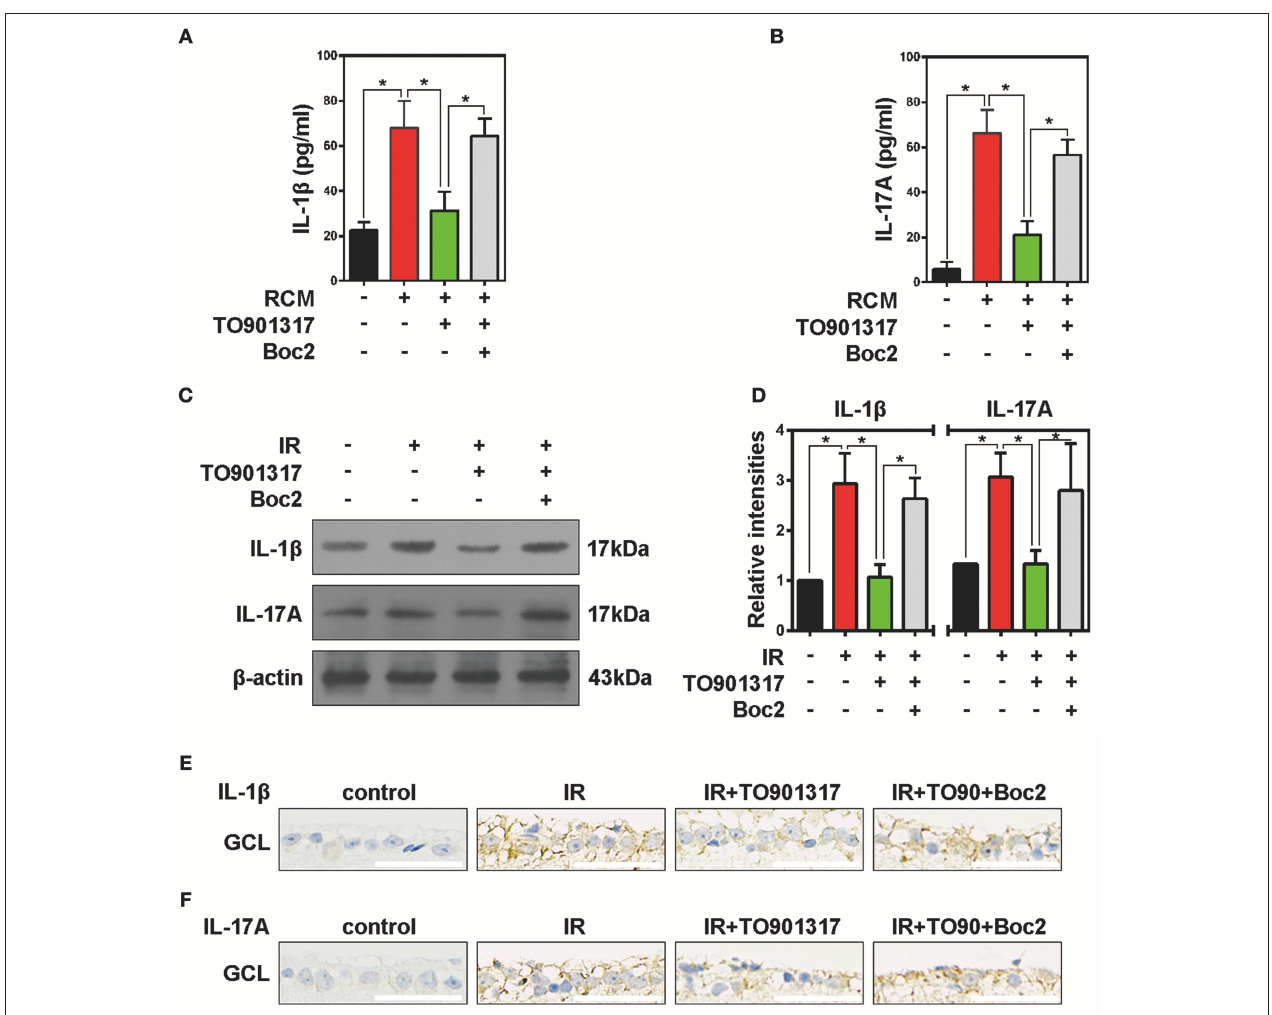
FIGURE 6 | The effects of TO901317 on retinal inflammation. (A) ELISA results show the secretion of IL-1 β by primary cultured RGCs after RCM or RCM + TO901317 stimulation. The data of three independent experiments are expressed as the means ± S.D. * P < 0.05, one-way ANOVA with Bonferroni post hoc test. (B) Secretion of IL-17A by primary cultured RGCs detected in ELISAs. The data of three independent experiments are expressed as the means ± S.D. * P < 0.05, one-way ANOVA with Bonferroni post hoc test. (C) Western blots showing the effects of TO901317 and TO901317 + Boc2 on IL-17A and IL-1 β expression in ischemic retinas. (D) Statistical analysis of the data shown in (C) . The data of three independent experiments are expressed as the means ± S.D. * P < 0.05, one-way ANOVA with Bonferroni post hoc test. (E) Representative immunohistochemical images of IL-1 β expression in the GCL. Scale bar = 50 µ m. (F) Representative immunohistochemical images of IL-17A expression in the GCL. Scale bar = 50 µ